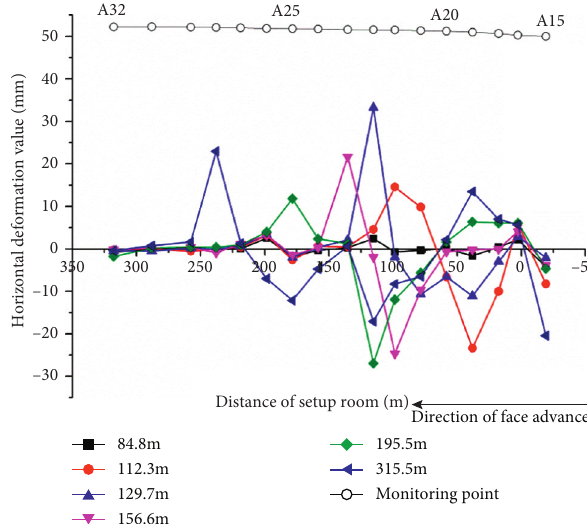
Figure 10: Horizontal deformation